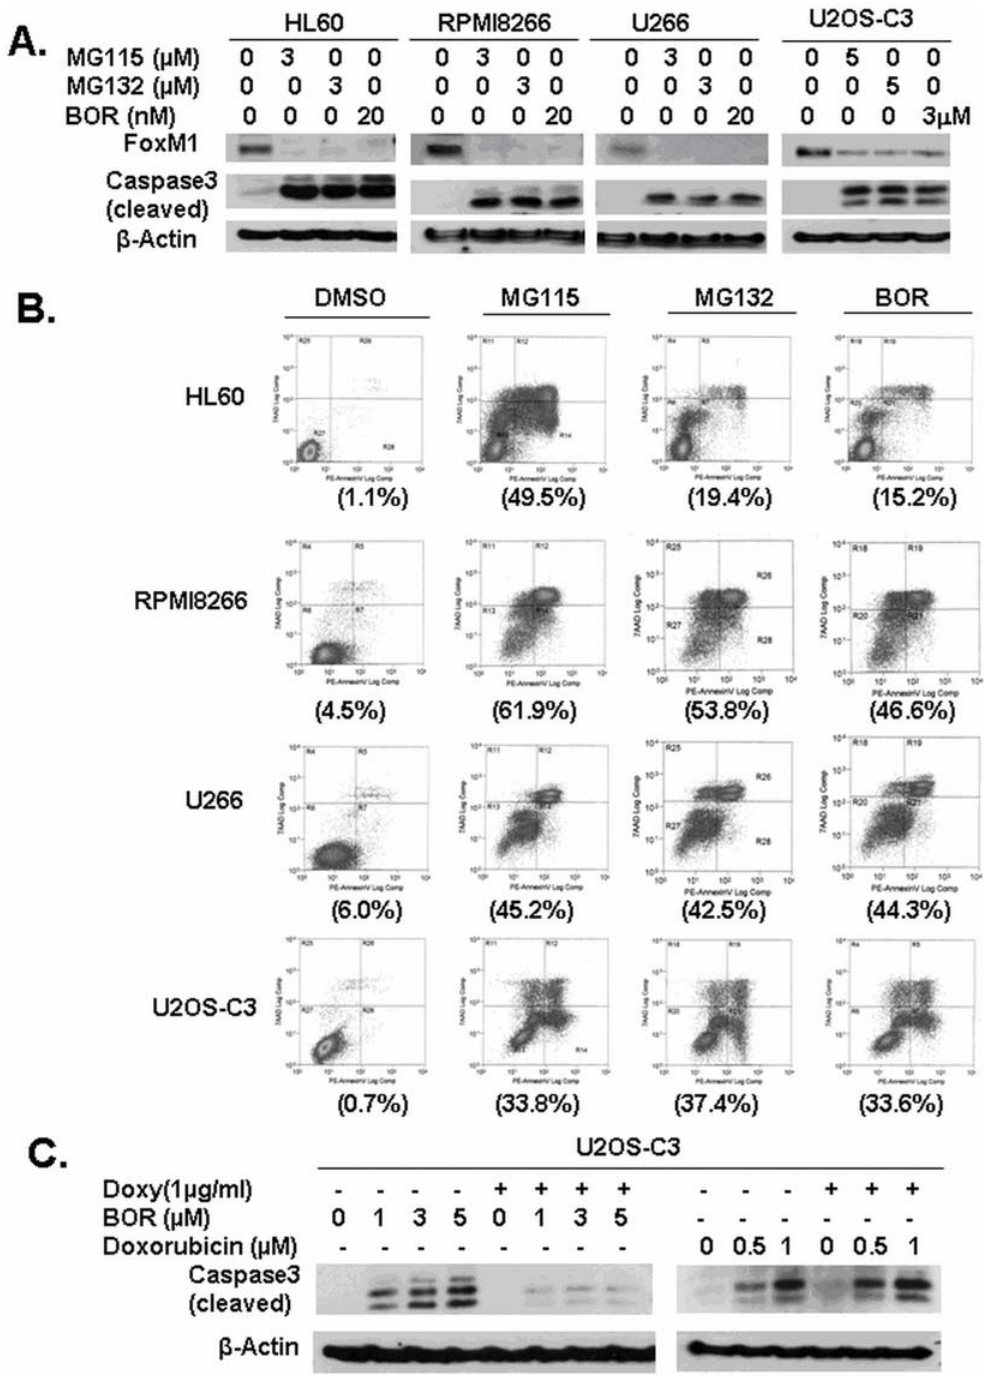
Figure 2. Proteasome inhibitors target FoxM1 protein and overexpression of FoxM1 partially protects cancer cell lines from proteasome inhibitor-induced apoptosis. (A) Proteasome inhibitors induce apoptosis and inhibit FoxM1 protein expression in multiple myeloma, leukemia and osteosarcoma cell lines. U266 and RPMI8226 multiple myeloma, HL-60 leukemia and U2OS-C3 osteosarcoma cell lines were treated with proteasome inhibitors MG115, MG132 and bortezomib (BOR). Apoptosis was assessed by immunoblotting for cleaved caspase-3 and FoxM1 protein levels were detected by immunoblotting. b -actin was used as the loading control. (B) Proteasome inhibitor-induced apoptosis wasfurtherquantifiedbyusingAnnexin V -PE/7AADstaining. U266 andRPMI8226 multiplemyeloma, HL-60leukemiaandU2OS-C3 osteosarcoma cell lines were grown in the absence or presence of indicated concentrations of proteasome inhibitors MG115, MG132 and bortezomib (BOR)for24 hours.Followingdrug treatment cellswere stained with AnnexinV- PE/7AAD andthen analyzedby flow cytometry. Percentage of apoptotic cells is shown in brackets. Concentrations of drugs are the same as in the Fig 2A. (C) Overexpression of FoxM1 specifically protects against cell death induced by Bortezomib. Overexpression of FoxM1 protected against cell death induced by increasing amount of bortezomib (BOR), but not that of doxorubicin. Immunoblotting was carried out with antibodies specific for cleaved caspase-3 and b -actin.